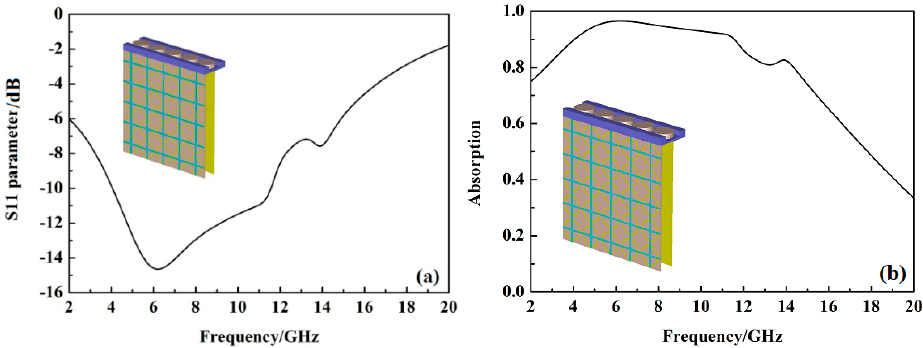
Figure 2. The S11 parameter and absorption when the rotatable metal plate is parallel to the rest of the layers, ( a ) the S11 parameter; ( b ) the absorption.